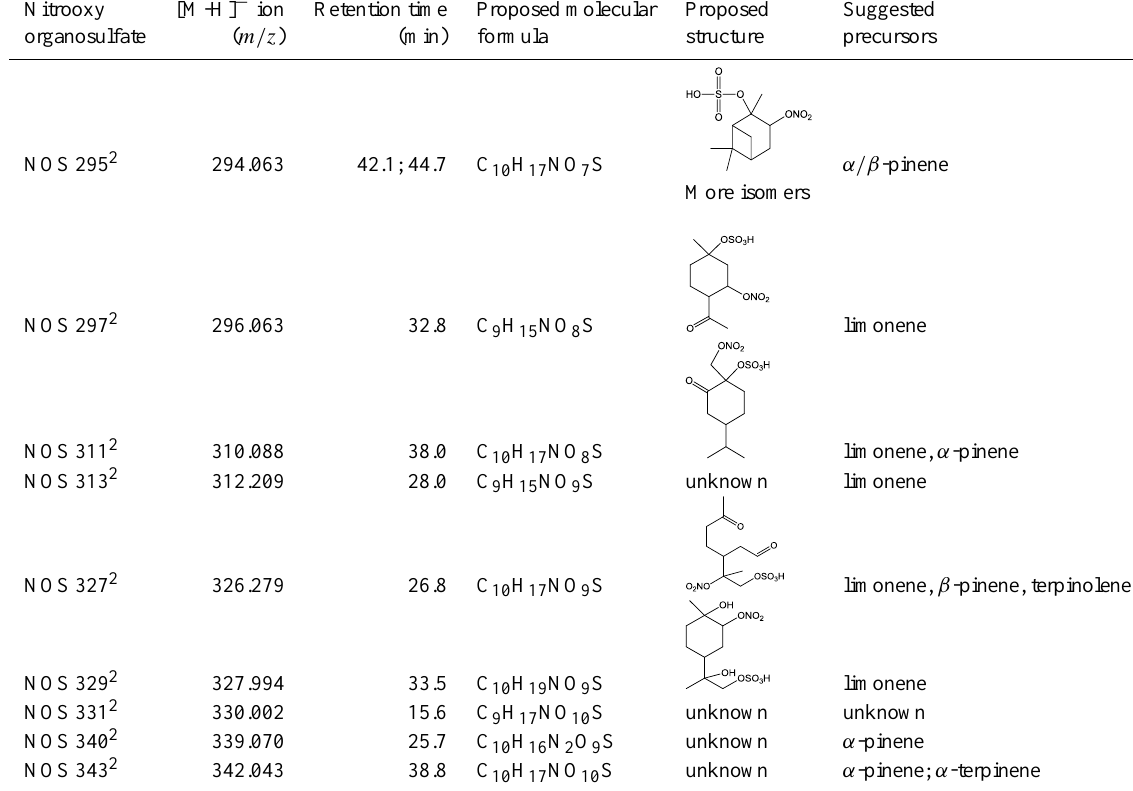
Table 3. Detected nitrooxy organosulfates (NOS) during the campaign. 1 Nitrooxy [M-H] - Retention Proposed Proposed structure Suggested precursors organosulfate ion (m/z) time (min) molecular formula